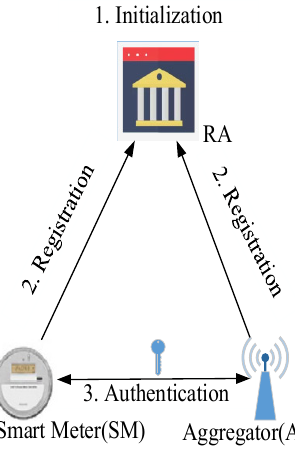
Figure 2. General overview of the proposed scheme. Table 1.